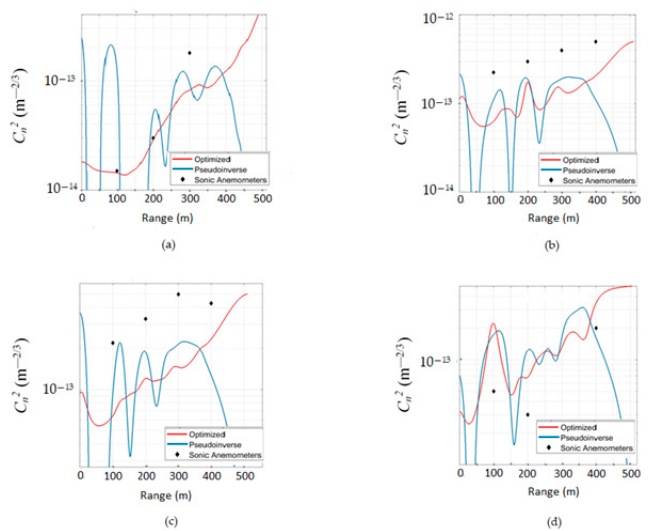
Figure 8. Comparison of time-lapse derived estimates with sonic anemometer measurements. ( a ) At 15:50 local (UTC—4), 27 June 2019; ( b ) At 11:30 local (UTC—4), 28 June 2019; ( c ) At 12:15 local (UTC—4), 28 June 2019 and ( d ) At 20: 45 local (UTC—4), 25 July 2019.